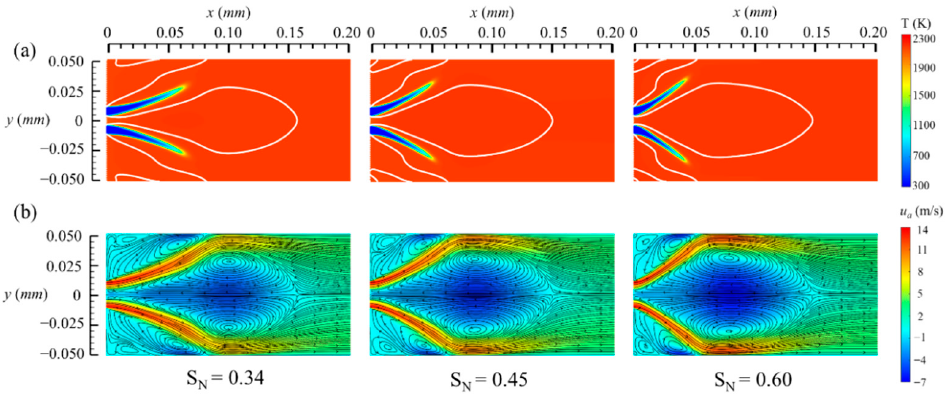
Figure 4. ( a ) Temperature contour with zero axial velocity isolines, and ( b ) axial velocity contour along with streamlines of different S N , where V a = 180, L/min and T i = 300 K.